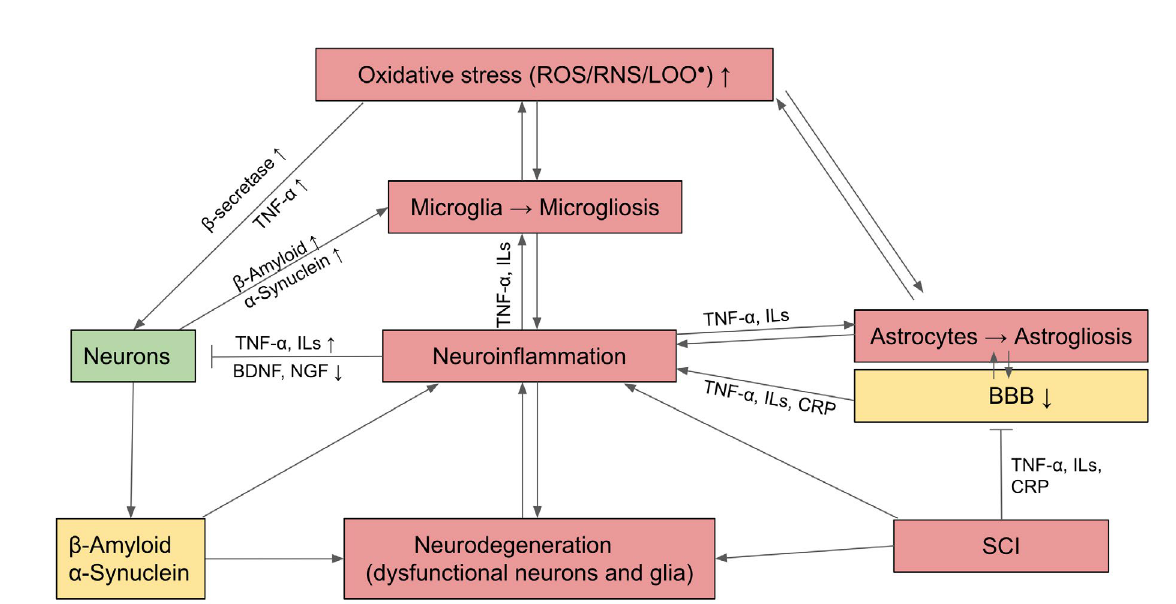
Figure 2. Mechanism of neurodegeneration through OS and activation of inflammatory astrocytes and microglia which undergo gliosis and cause neuroinflammation. BDNF: brain-derived neurotrophic factor; CRP: C-reactive protein; NGF: nerve growth